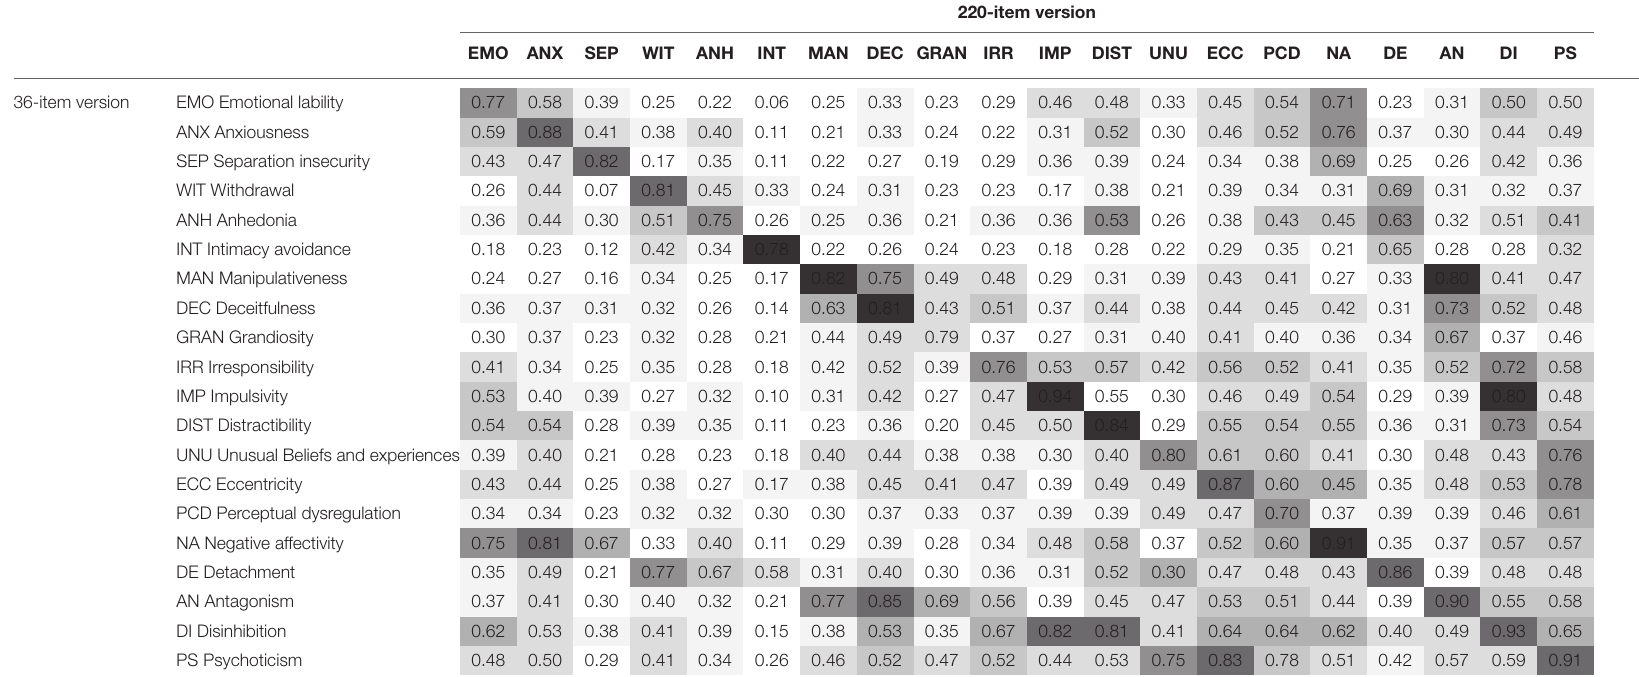
TABLE 5 | Correlations of selected facets and domains between the 220-item and the 36-item